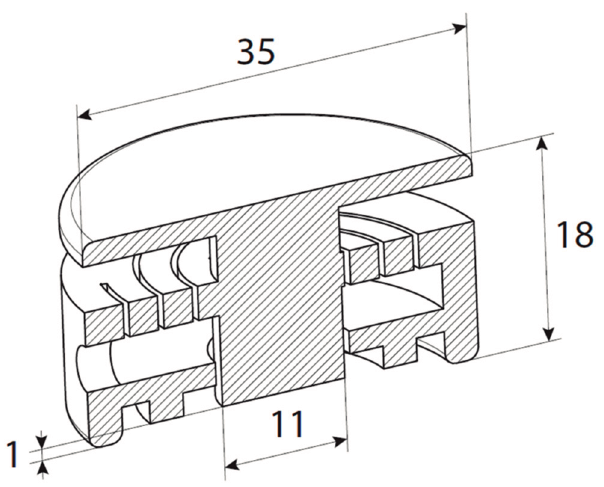
Figure 3. Technical drawing of the mechanical applicator (all dimensions at scale in